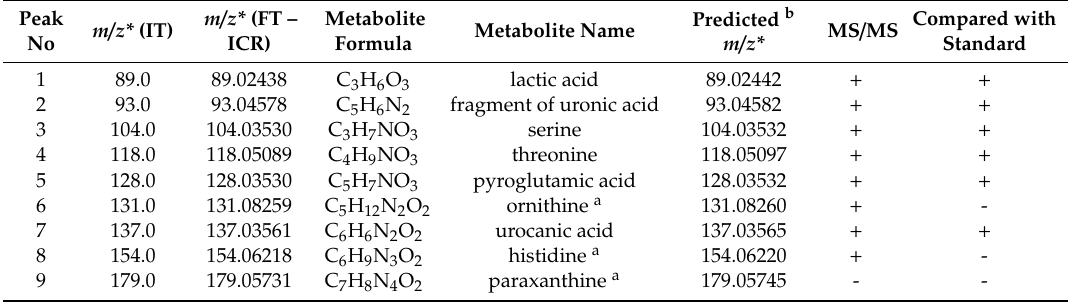
Table 1. Identification of peaks in the mass spectra of sweat